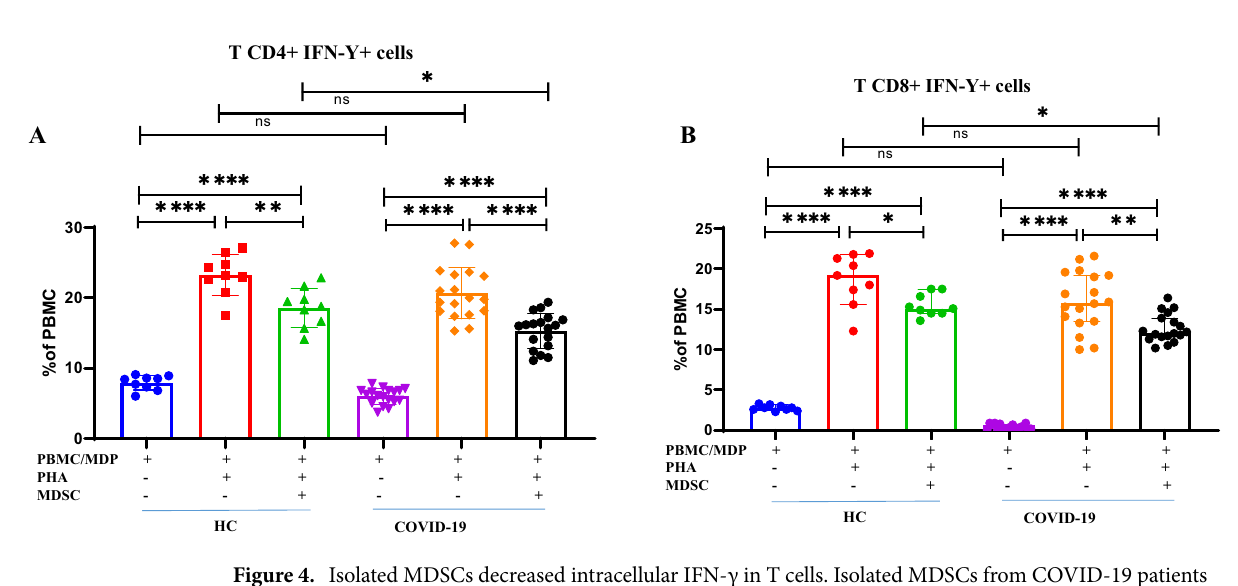
Figure 4. Isolated MDSCs decreased intracellular IFN-γ in T cells. Isolated MDSCs from COVID-19 patients were co-cultured with autologous MDPs from the patients and homologous PBMCs from HCs in the presence of PHA for 3 days. ( A,B ) Dot plots show the percentage of CD4 + IFN-γ + T cells from 18 COVID-19 patients and 9 HCs. All values are presented as the mean and 5–95% percentile and comparisons made between control and patient groups were performed using ANOVA followed by a Tukey’s test. *P < 0.01, **P < 0.001, ***P < 0.0001 and ****P < 0.0001. HC healthy control, P patients, MDP MDSC depleted